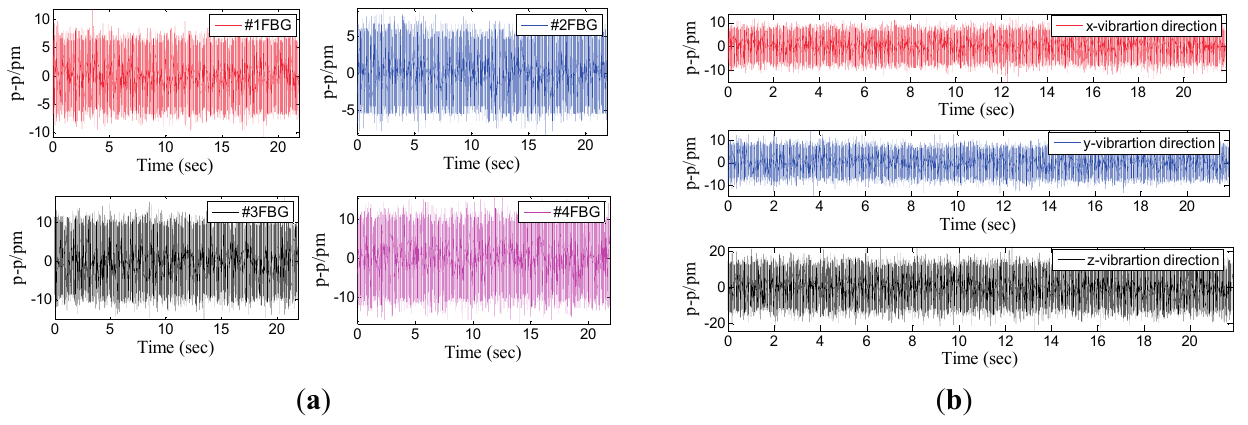
Figure 18. Response of each FBG and three directions without excitation.